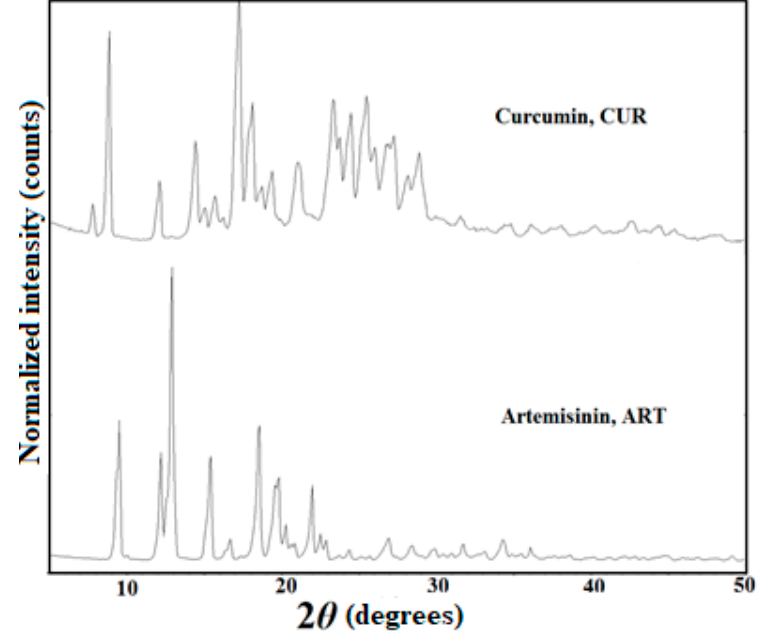
Figure 5. PXRD patterns of starting materials CUR (form 1) and ART (form 1).